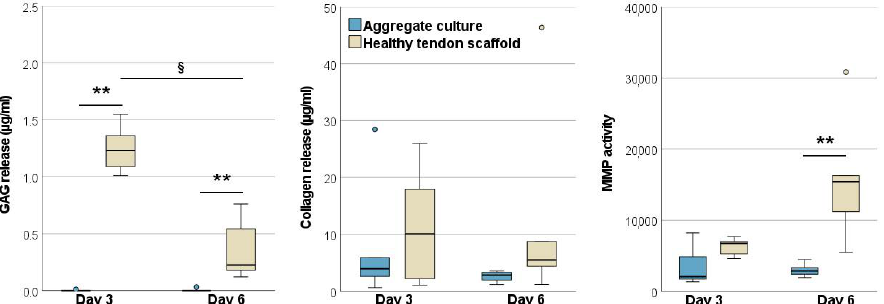
Figure 3. Glycosaminoglycan, total collagen and matrix metalloproteinase (MMP) activity in the supernatants of MSC aggregate cultures and healthy tendon scaffold cultures. Asterisks indicate significant differences between groups with p < 0.01 (**). Significant differences over time are indicated by paragraph symbols for healthy tendon scaffold cultures ( p < 0.05). Data were obtained with MSCs from n = 6